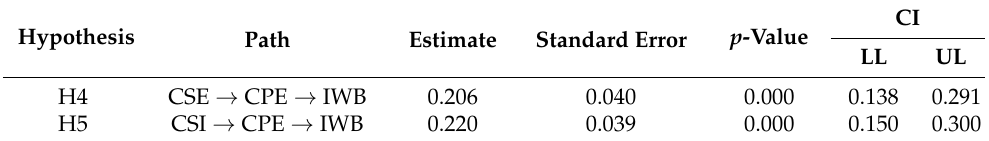
Table 4. Mediation effect.